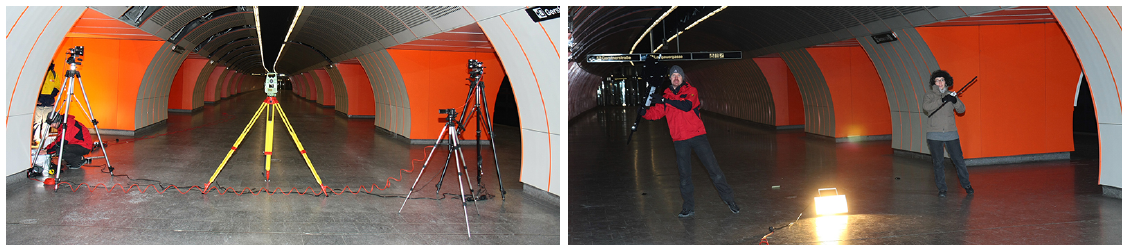
Figure 25. Test environment in a metro underground station.